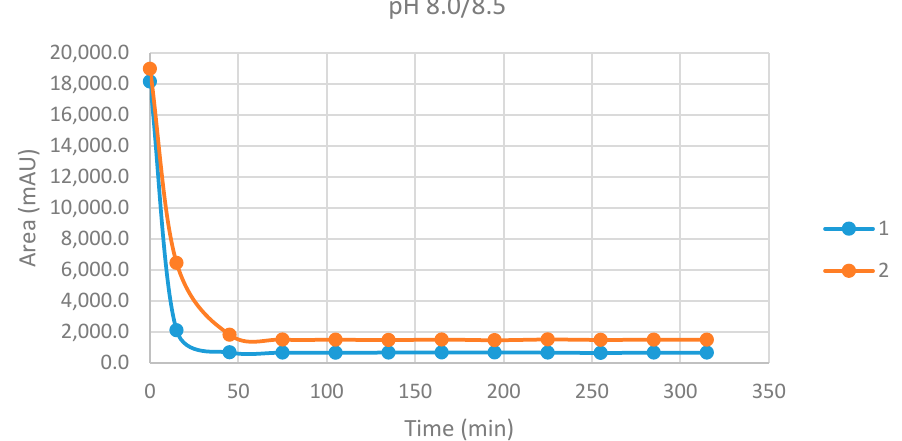
Figure 3. Change in the chromatographic peak area of chalcones 1 and 2 in the chalcone–GSH incubations at pH 8.0/8.5.